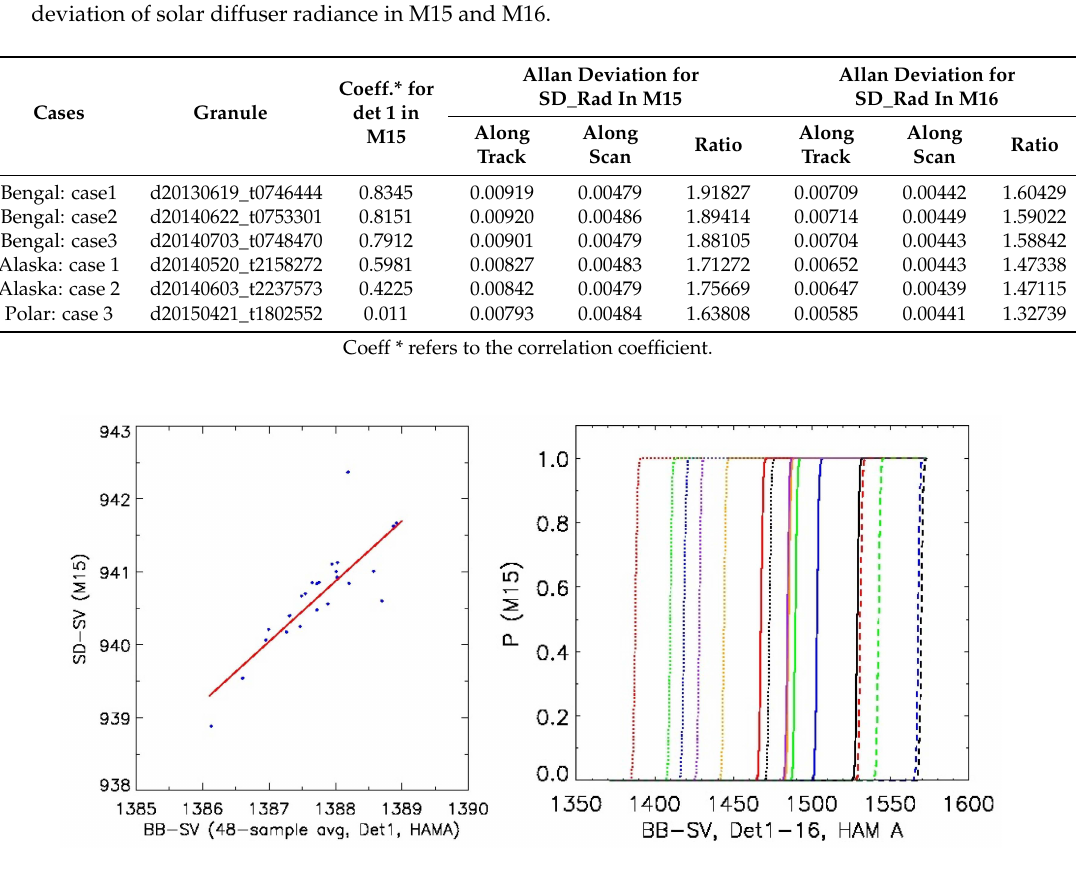
Figure 16. Linear correlation between dBB and dSD ( left ) and the cumulative histogram of 48-sample averaged dBB ( right ) for detector 1 in HAM side A and band M15 over a granule of the Bay of Bengal in case1. Table 4. Correlation coefficients between dBB and dSD, as well as the maximum horizontal distance from dBB and dSD in